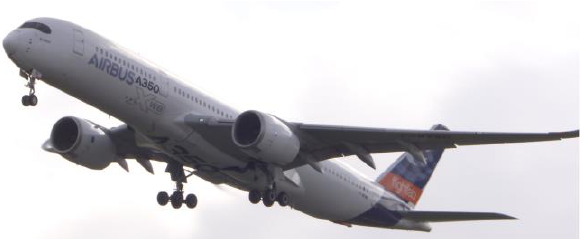
Fig.11. Airbus A350 flight on 100% SAF (2021)